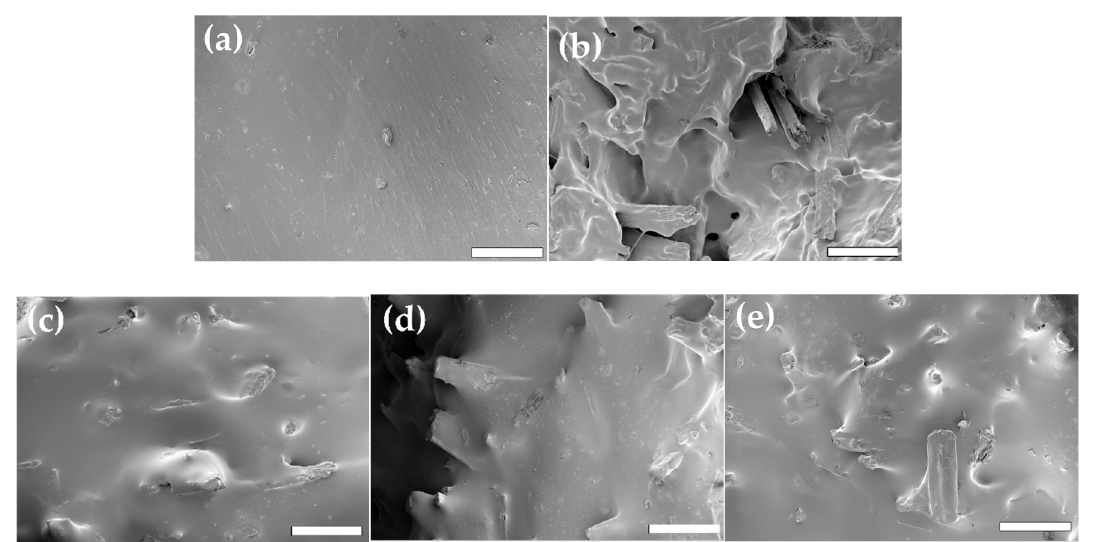
Figure 3. SEM images of the fracture surfaces of ( a ) ASKLTPU30; ( b ) RJF/ASKLTPU30 10/90; ( c ) PJF200/ASKLTPU30 10/90; ( d ) PJF250/ASKLTPU30 10/90; and ( e ) PJF300/ASKLTPU30 10/90 (×300, scale bar: 200 μ m).